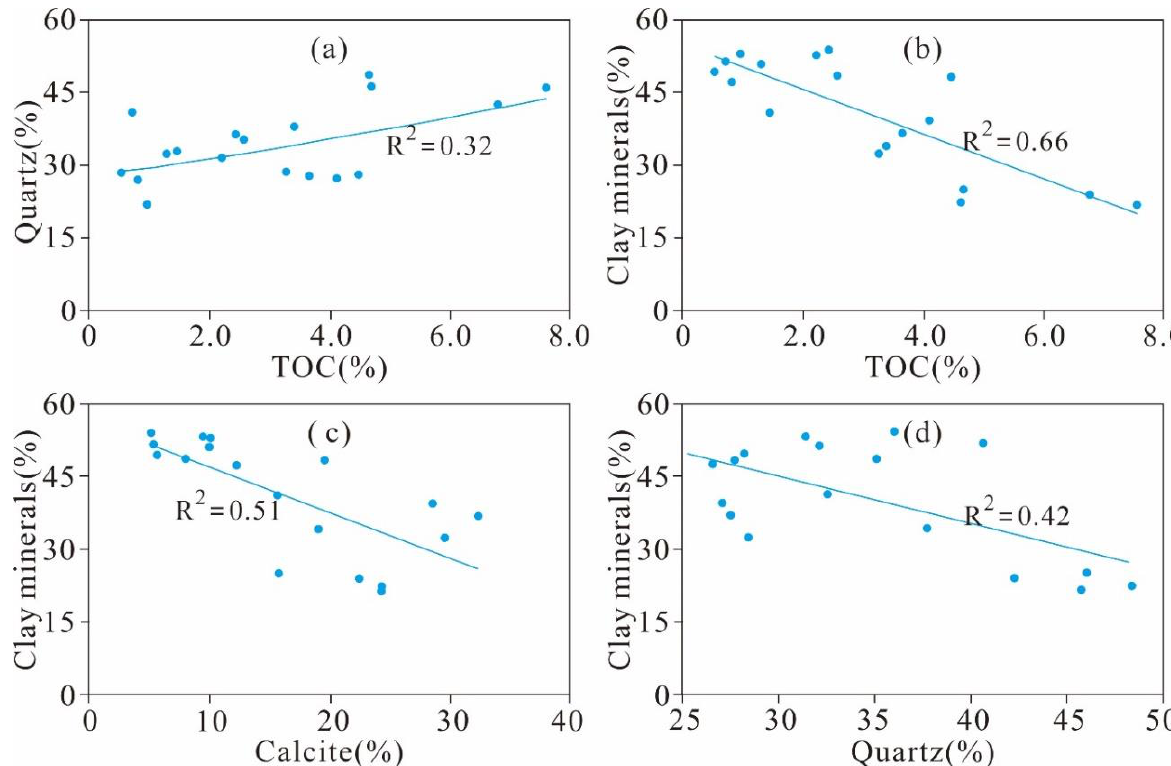
Figure 7. Cross plots of ( a ) quartz vs. TOC; ( b ) clays vs. TOC; ( c ) clay vs. calcite; ( d ) clay vs. quartz.